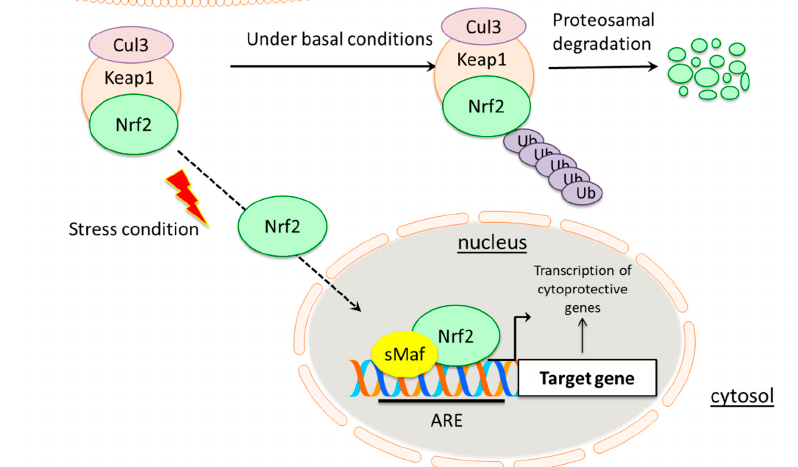
Figure 2. NRF2 regulation by KEAP1. Under basal conditions, NRF2 is constantly ubiquitinated through KEAP1 and degraded in the proteasome in cytosol. Under stress conditions, KEAP1-NRF2 interaction is stopped and free NRF2 translocates into nucleus. Then, NRF2 forms heterodimers with sMaf and binds to ARE sites within regulatory sites of antioxidant and detoxification genes. ARE, antioxidant response element; KEAP1, Kelch-like ECH-associated protein1; NRF2, nuclear erythroid-2 like factor-2; Retinoic X receptor alpha sMafs, small musculoaponeurotic fibrosarcoma oncogene